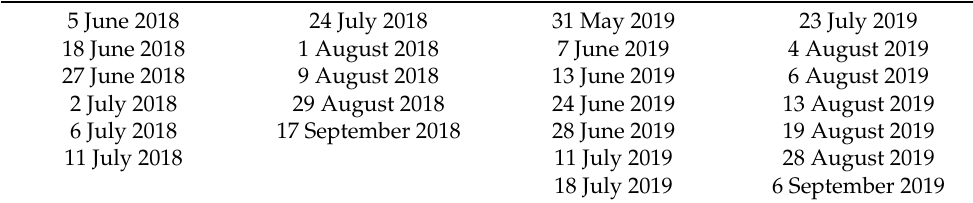
Table 2. MicaSense RedEdge multispectral camera specifications.